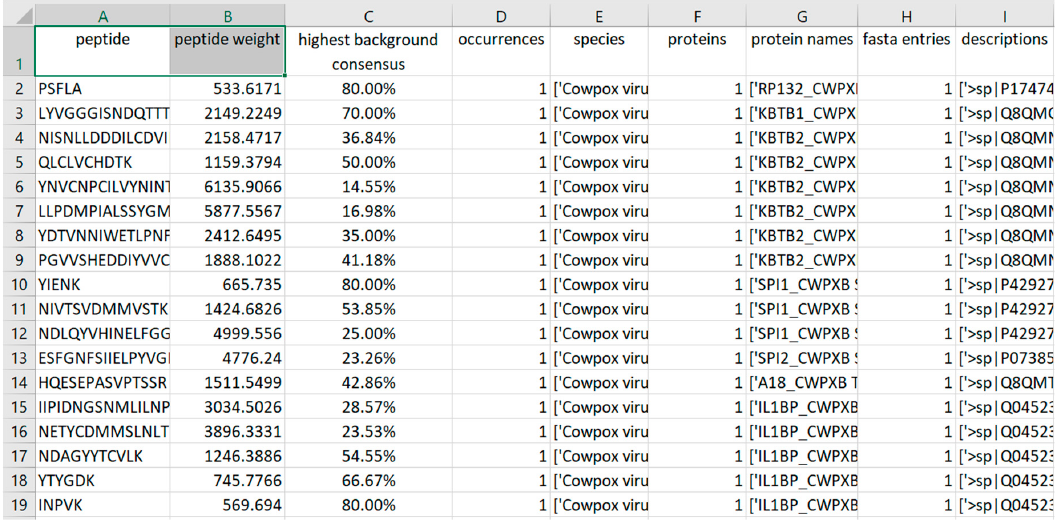
Table 1. Alphabetically ordered list of arenavirus species used for the performance benchmarking. The reader is referred to [23] for further details on these arenaviruses.